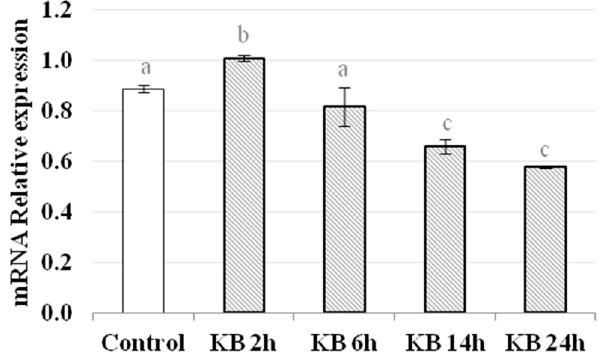
Figure 3. Nrf2 mRNA expression by real-time PCR in control HMEC-1 cells and cells treated with KB for 2, 6, 14 or 24 h. mRNA expression was normalized to the level of the housekeeping gene GAPDH. Data are the means ± SD of three independent experiments. Data not sharing a common letter are significantly different, p <